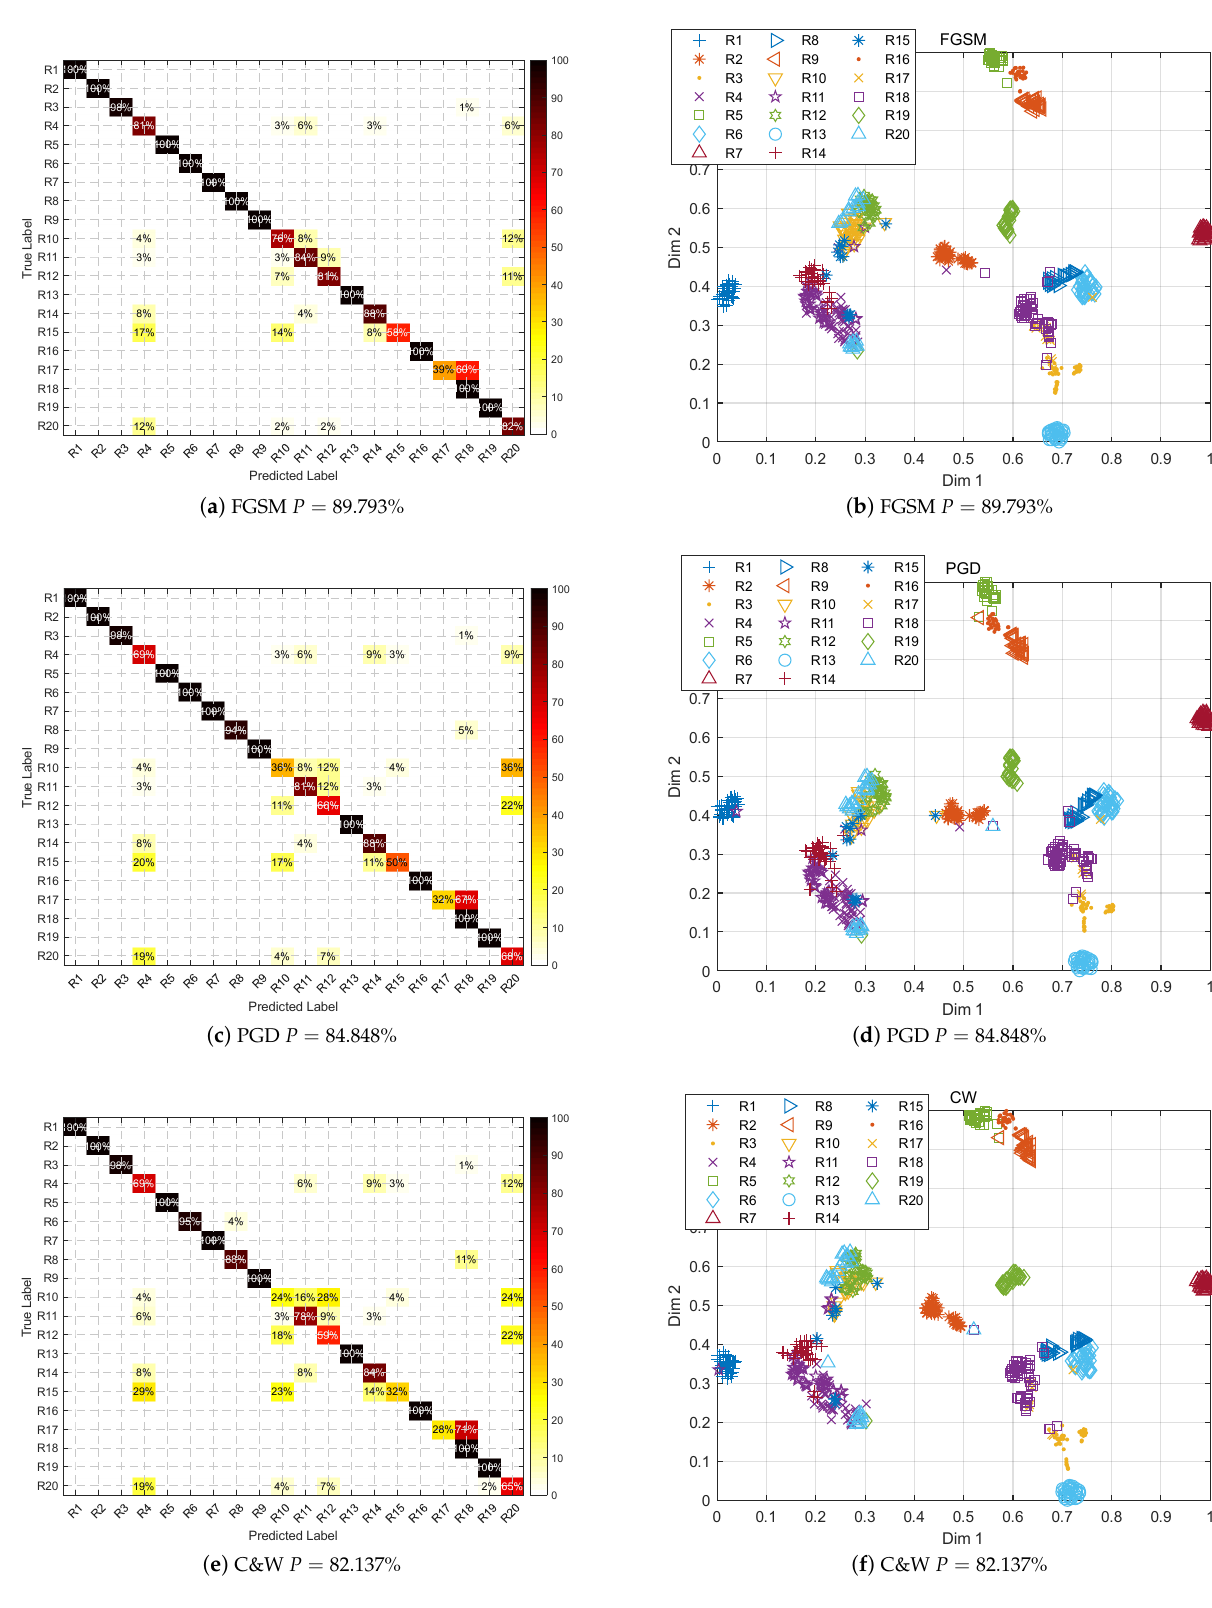
Figure 15. Identification performance and the feature distribution with attacks of PSR = − 32 dB after AT for Dataset 1. The figures of the first column represents the confusion matrices, and the second column is for low-dimensional feature